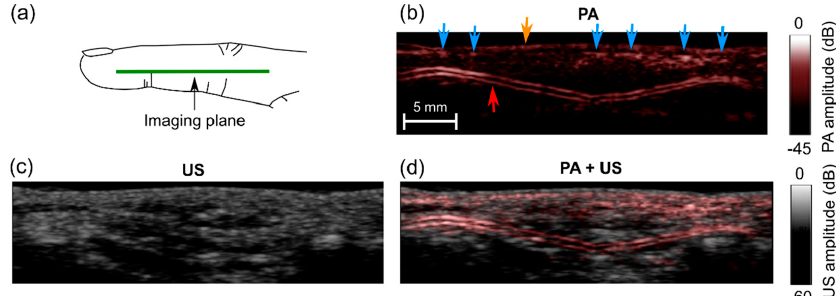
Figure 6. Photoacoustic (PA) and ultrasound (US) images of a middle finger of a human volunteer. ( a ) Schematic indicating the location of the imaging plane; ( b ) PA image; ( c ) US image; ( d ) PA + US image overlay. In the PA image ( b ), signals from low depths may have corresponded to veins (blue arrows) and the skin surface (yellow arrow); signals from a two-layered structure may have corresponded to a digital artery (red arrow). These images were reconstructed and displayed in real-time on logarithmic scales. Here, they are presented without the uppermost 5 mm, which contained the water. Pulsations of the digital artery were apparent (Supplementary Materials; Video S2).